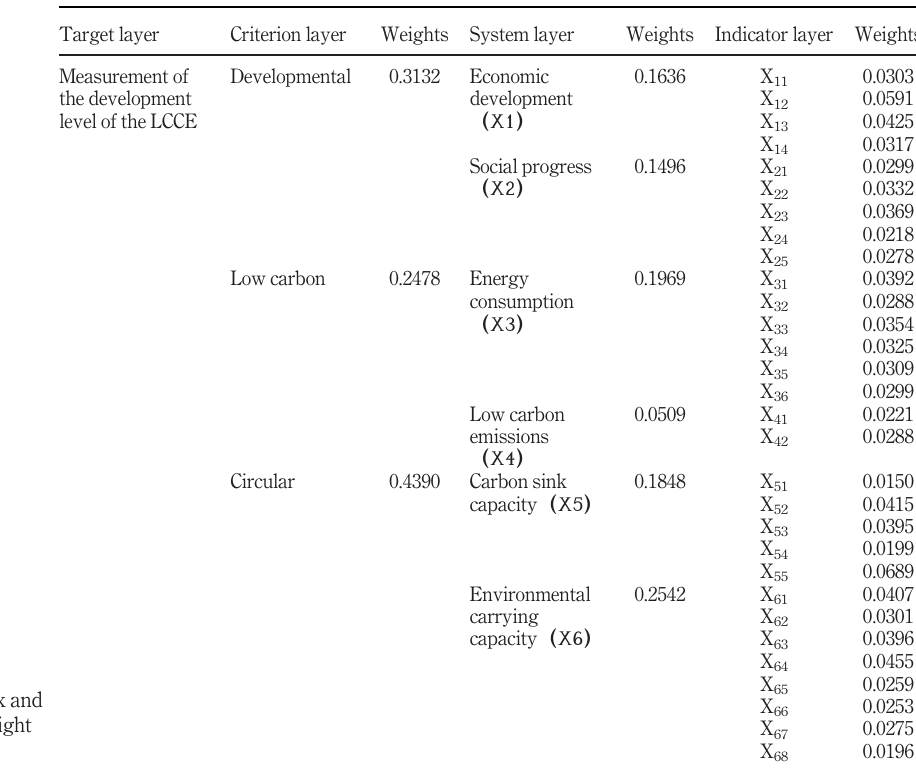
Table 2. Evaluation index